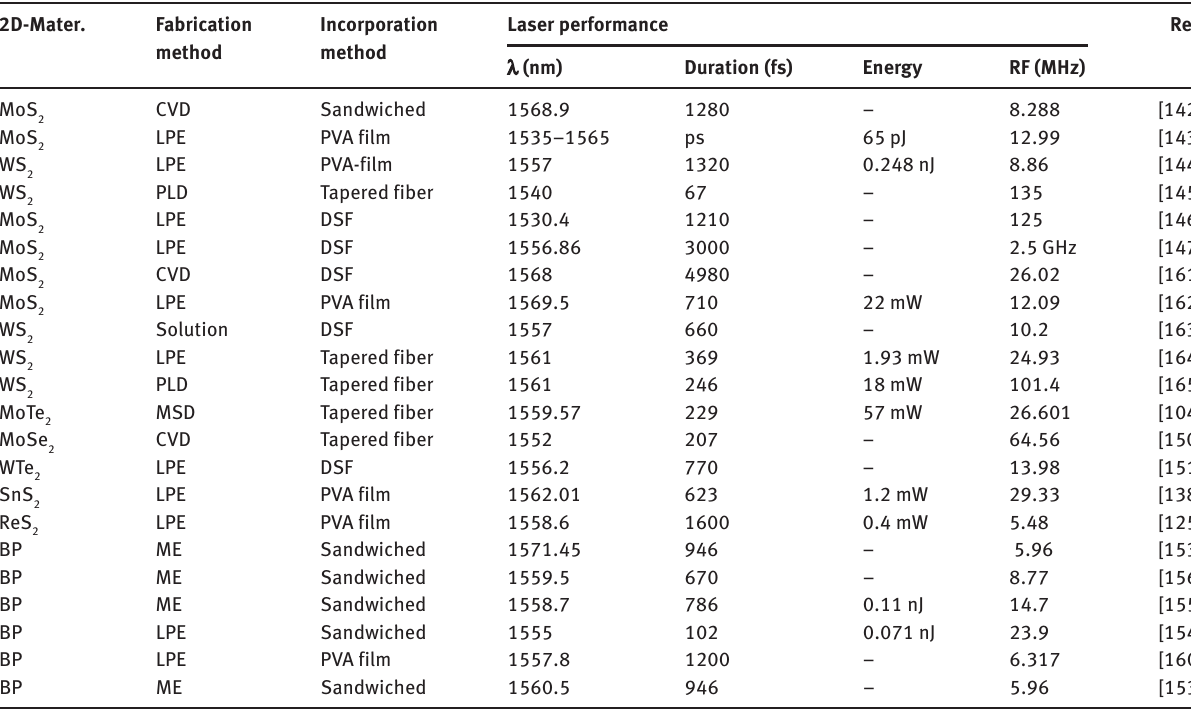
Table 3: Summarization of mode-locked erbium-doped fiber lasers (EDFLs) based on transition-metal dichalcogenides (TMDCs) and black phosphorus (BP) saturable absorbers (SAs) at 1.55 μ